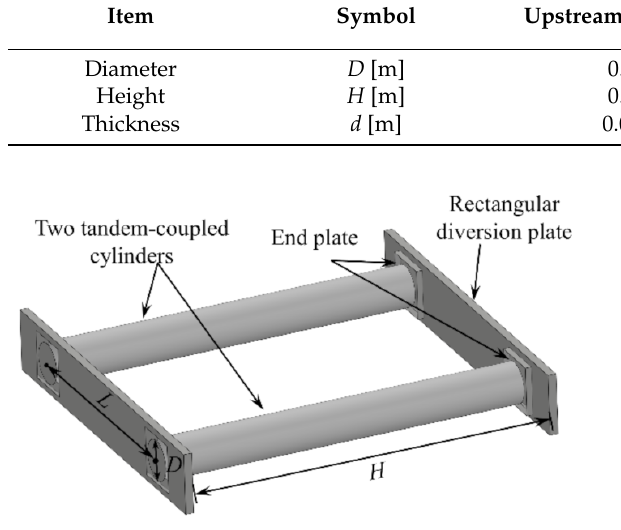
Figure 7. Test circular